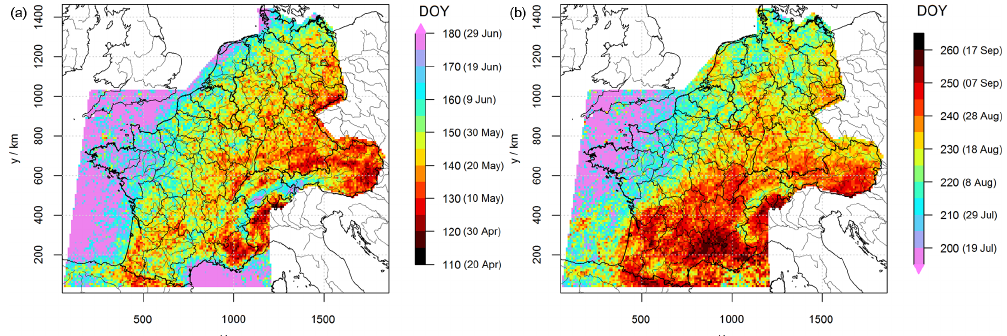
Figure 8. Mean day of year when the first (a) and last (b) thunderstorm days occur.